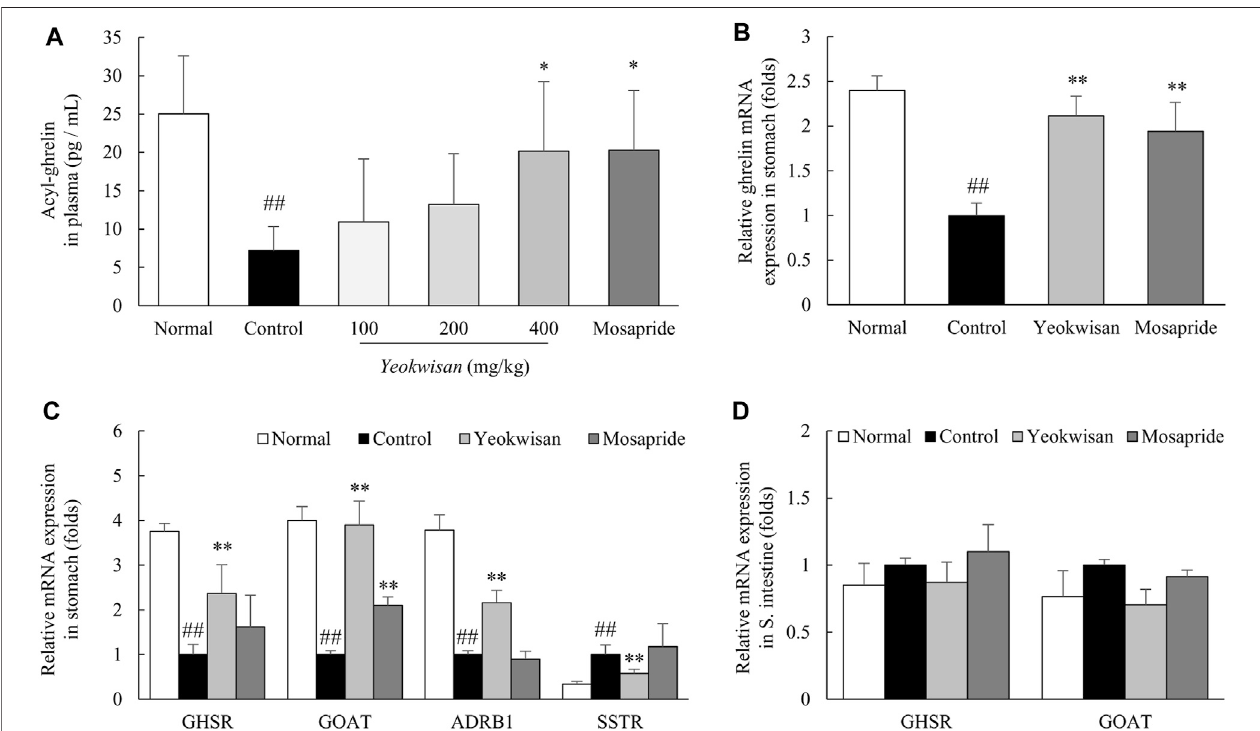
FIGURE 6 | Effects of Yeokwisan on the level of ghrelin in plasma, and ghrelin-related genes in stomach and small intestine tissues. The level of acyl-ghrelin in plasmawasdeterminedusingELISA (A) .mRNAexpressionanalysesofghrelininstomachtissue (B) andghrelin-associatedgenesinthestomach (C) andsmallintestine (D) were performed. The Yeokwisan group was treated with a dose of 400 mg/kg in (B – F) . The data are presented as the mean ± SEM. ## p < 0.01 compared with the normal group; * p < 0.05, ** p < 0.01 compared with the control group. GHSR, growth hormone secretagogue receptor; GOAT, ghrelin-O-acyltransferase; ADRB1, adrenergic receptor β 1; SSTR, somatostatin